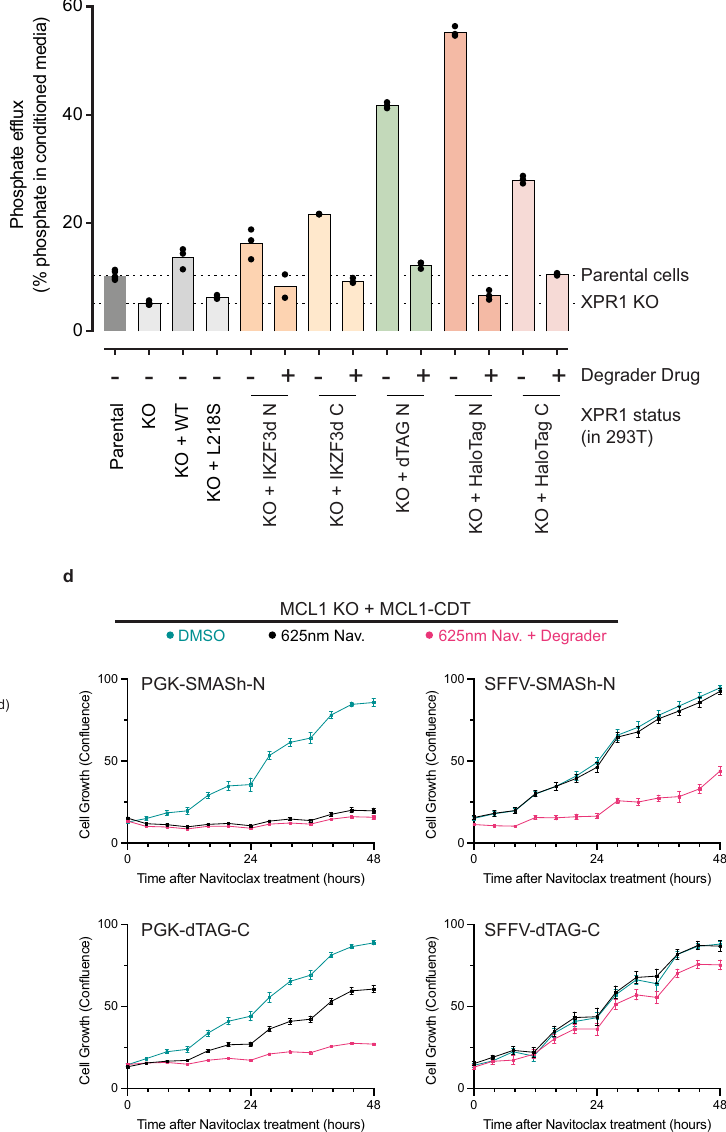
Fig. 4 | Validation of functional activity for XPR1- and MCL1-CDT fusion pro- teins.a ComparisonofexpressionlevelsforXPR1degronfusionproteinsinvarious cell lines. Expression was determined by quantifying the western blot V5 band intensity and normalizing it to a Vinculin loading control. b Phosphate ef fl ux activity of XPR1 degron fusion proteins. 293T cells endogenously express XPR1, which was inactivated using CRISPR/Cas9 (XPR1-KO) followed by re-expression of wild-type XPR1 (WT), a hypomorphic allele (L218S), or the indicated SFFV-driven degron fusion proteins. Three days after the addition of degrader drug (1 μ M measuredby “ loading cells ” for45min with 32 PO 4 3 − , washingawayanyextracellular 32 P,andthenincubatingthecellsfor60minandmeasuringthepercentageof 32 Pin the conditioned medium compared to cellular lysates. The bar height represents